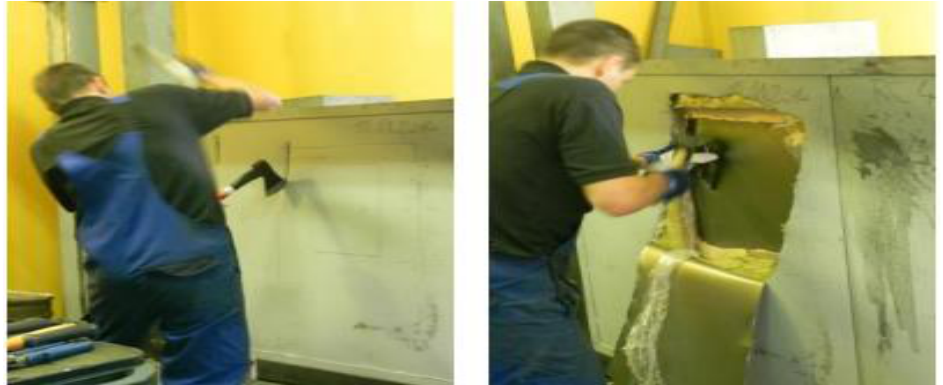
Figure 1 . 4th Resistance Class panel walls break-through testing [17] .